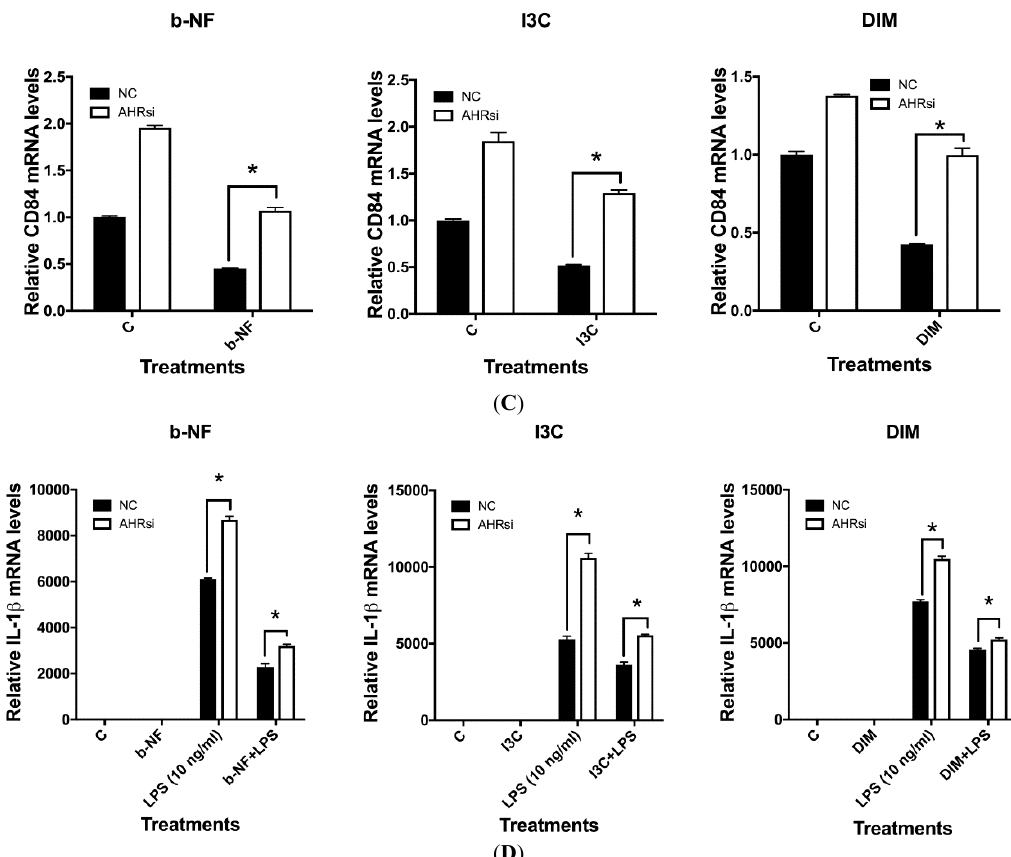
Figure 7. Effect of AHR siRNA on I3C (25 µM), DIM (10 µM) and b-NF (10 µM) modulation of IL-1 β , CD84 and CYP1B1 mRNA in u-THP-1 cells. Experiments using AHR siRNA were conducted in u-THP-1 cells as described in Materials and Methods. After treatments, total RNA was isolated and AHR, CD84, CYP1B1 and IL-1 β mRNA were determined using RT-PCR. ( A ) Effects of AHR siRNA on AHR mRNA levels; ( B ) Effects of AHR siRNA on CYP1B1 mRNA levels; ( C ) Effects of AHR siRNA on CD84 mRNA levels; ( D ) Effects of AHR siRNA on LPS induction of IL-1 β mRNA levels. Results are expressed as mean ± SD ( n = 3). * indicates significant difference from vehicle control at p ≤ 0.05.